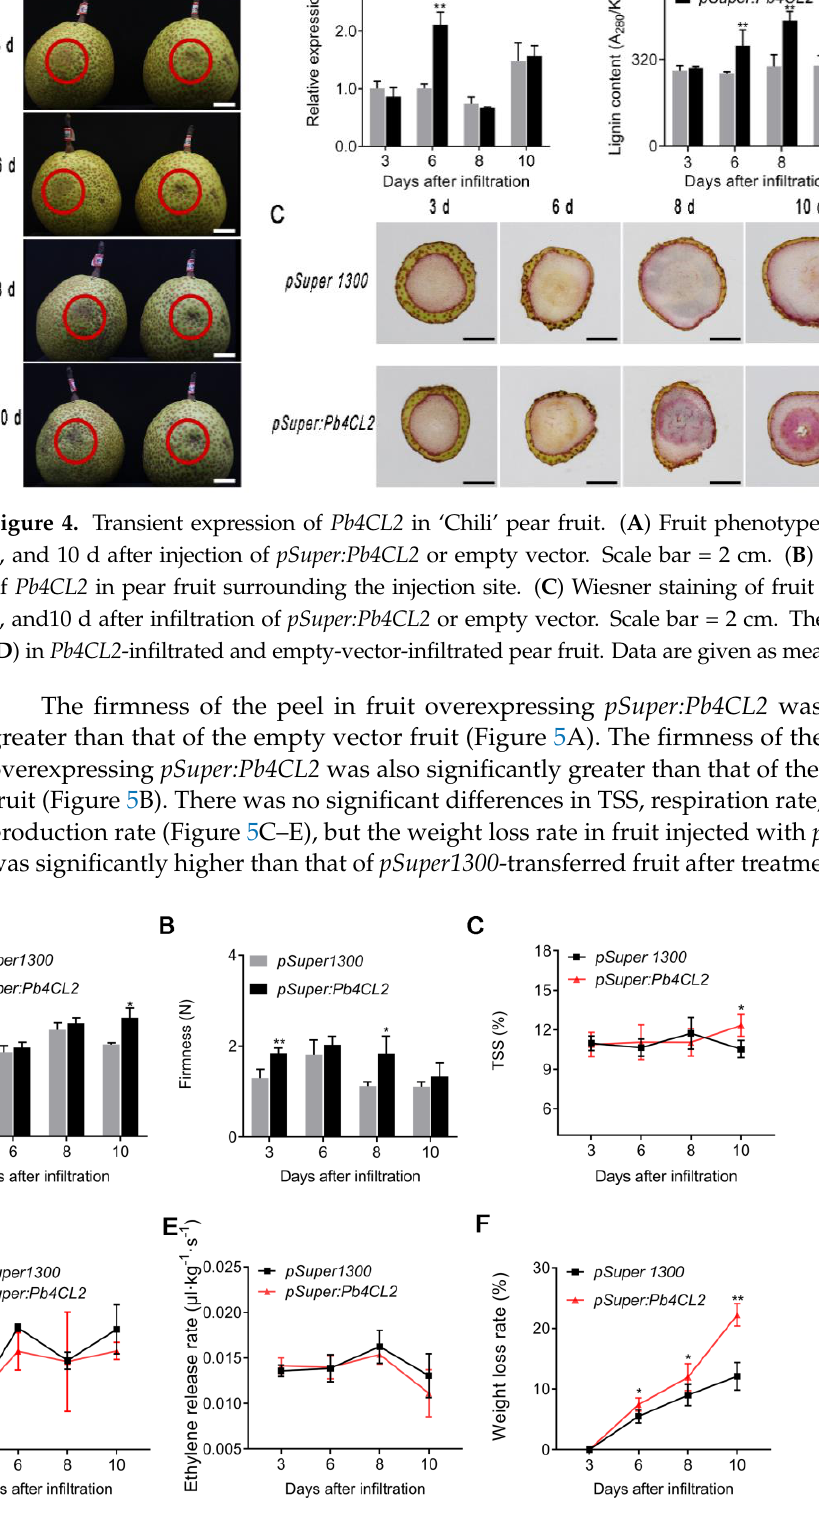
Figure 5. Firmness, TSS content, weight loss rate, respiratory rate, and ethylene production rate of ‘Chili’ pear fruit after injection of pSuper:Pb4CL2 or empty vector. Firmness of peel ( A ) and pulp ( B ) in Pb4CL 2-infiltrated and empty-vector-infiltrated pear fruit. The TSS content ( C ), respiratory rate ( D ), ethylene production rate ( E ), and weight loss rate ( F ) of fruit at 3, 6, 8, and 10 d after infiltration. Data are given as mean ± SD (n = 3).